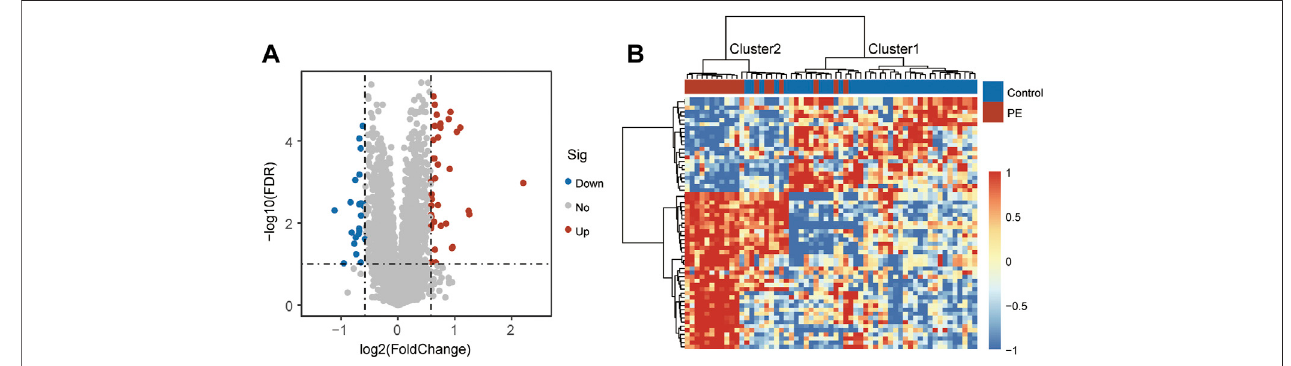
FIGURE 2 | Functional enrichment analysis. (A) Enriched function terms and network of up-regulated differentially expressed genes. (B) Enriched function terms and network of down-regulated differentially expressed genes.